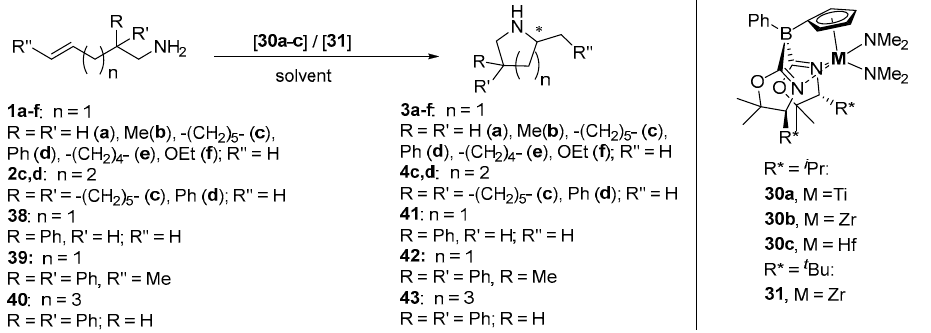
Table 10. Catalytic asymmetric hydroamination of 1a – f , 2c , d and 38 – 40 using chiral group IV cat- alysts 30a – c and 31 a